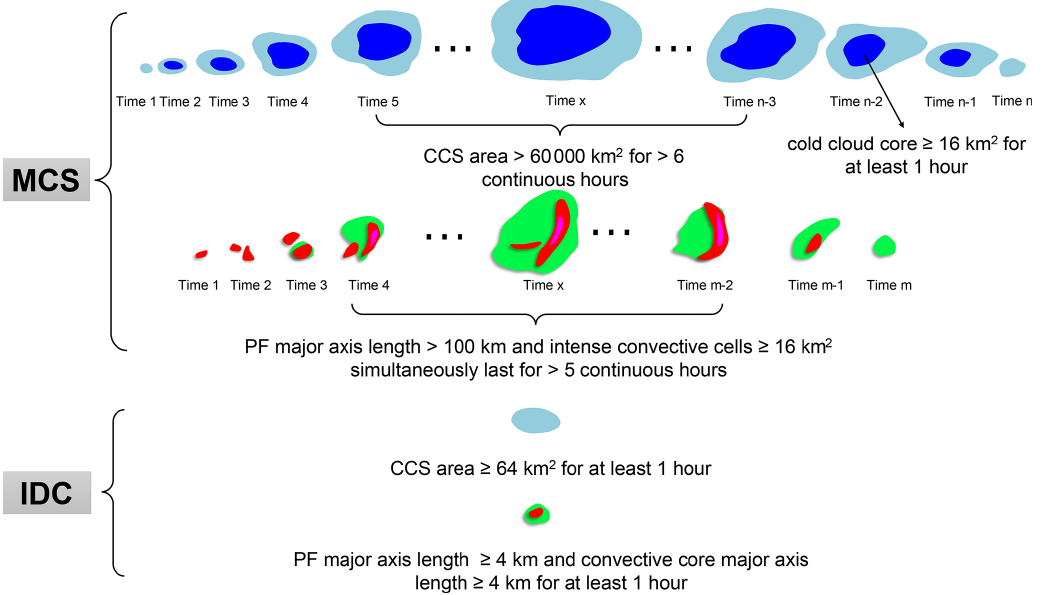
Figure 4. Definition of MCS and IDC based on the FLEXTRKR algorithm shown in Fig. 3 and the specific threshold values used in the